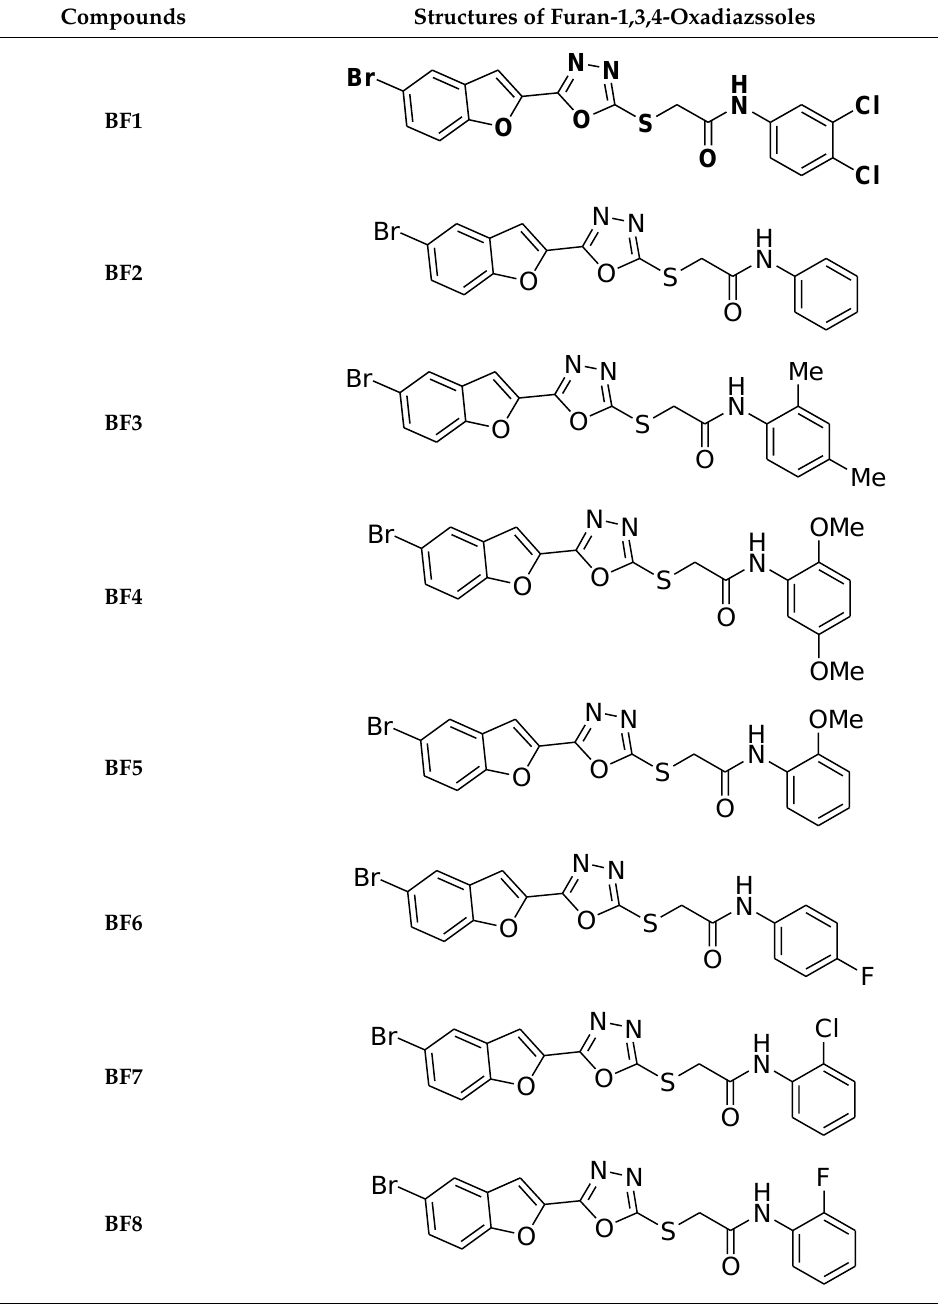
Table 5. Structures of synthetic furan-1,3,4-oxadiazoles BF1–BF16 . Compounds